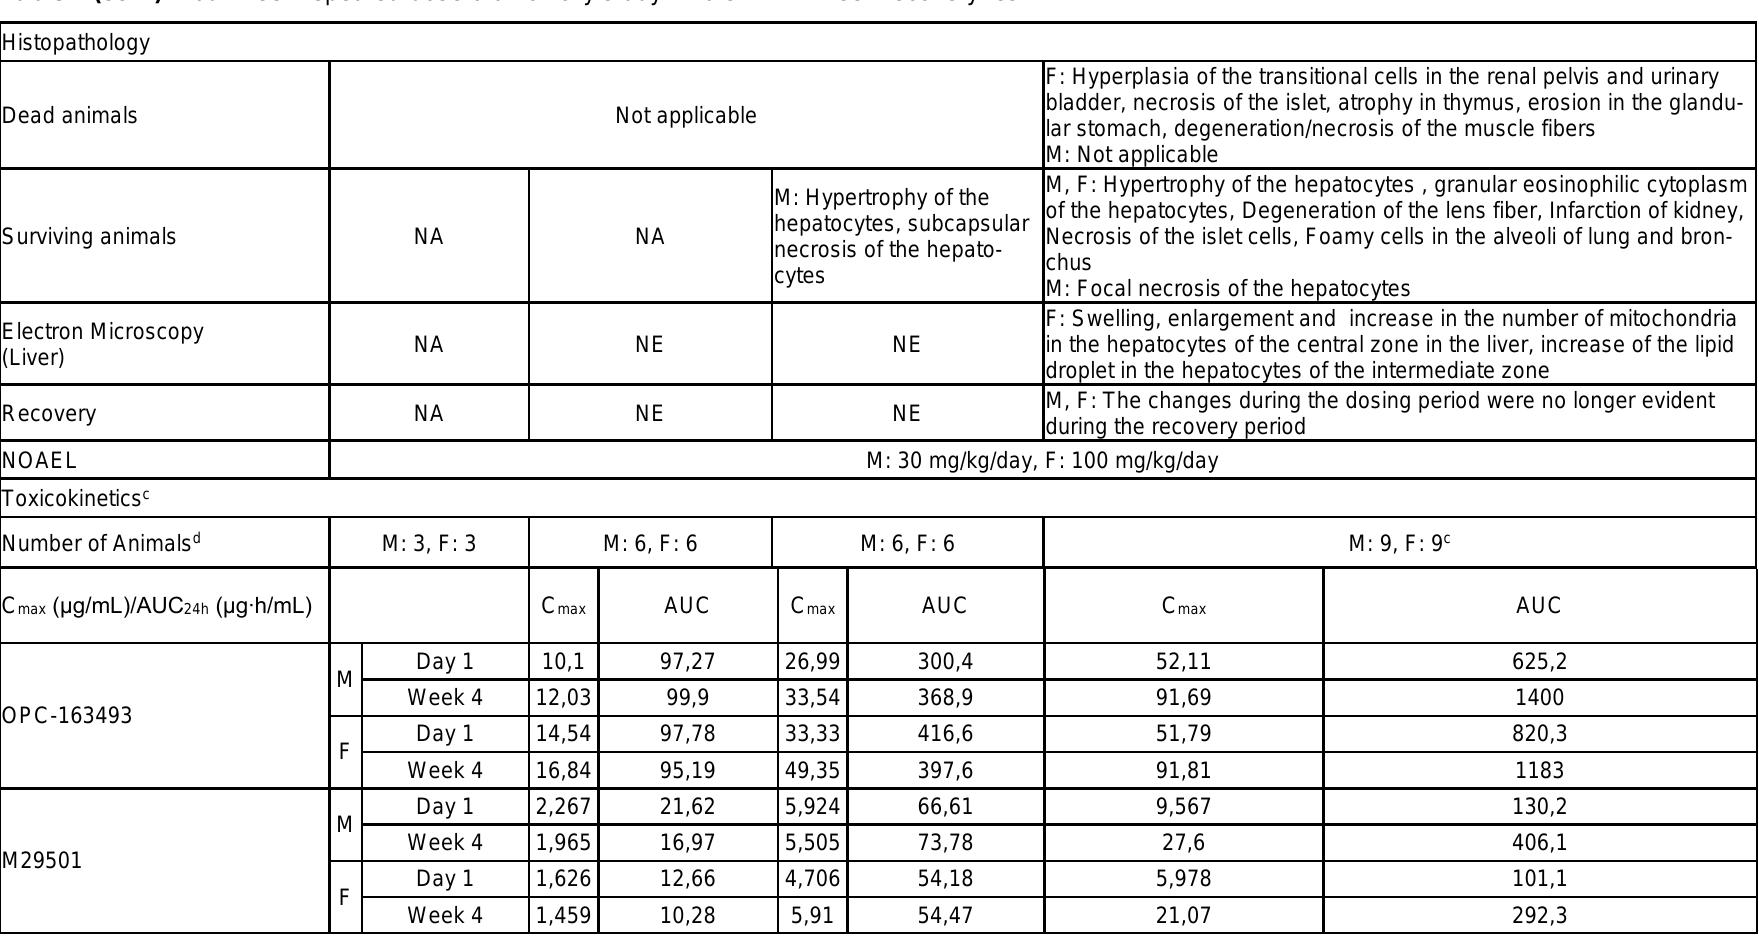
Table 2 (cont): Four-week repeated-dose oral toxicity study in rats with 4-week recovery test Histopathology